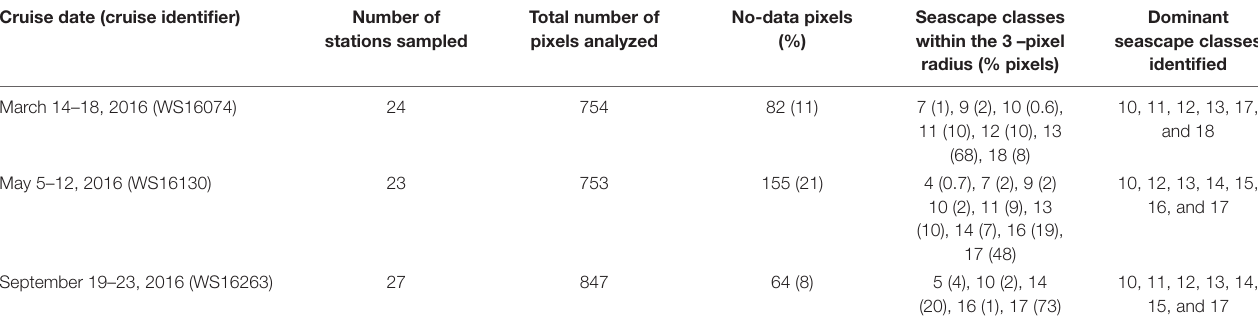
FIGURE 2 | Schematic illustration of the study workflow for the identification of phytoplankton groups and a phy spectral signatures in sampled seascape classes based on hierarchical agglomerative clustering (HAC) analysis. Canonical correspondence analysis (CCA) was used to examine quantitative relationships between seascape classes, in situ environmental variables (temperature, salinity, nutrients, and CDOM), and phytoplankton groups derived from CHEMTAX analysis. Match-ups of station clusters derived from HAC analysis with corresponding seascape classes identified at sampled sites were conducted to unveil qualitative relationships between seascapes and phytoplankton proxy data (a phy spectra and HPLC pigments). To evaluate the extent to which phytoplankton community composition can be assessed with bio-optical data, similarity analyses were conducted using the cophenetic index to compare dendrograms generated with HPLC pigments versus those from a phy spectra. TABLE 2 | Seascape classes identified across all sampled stations during the three field